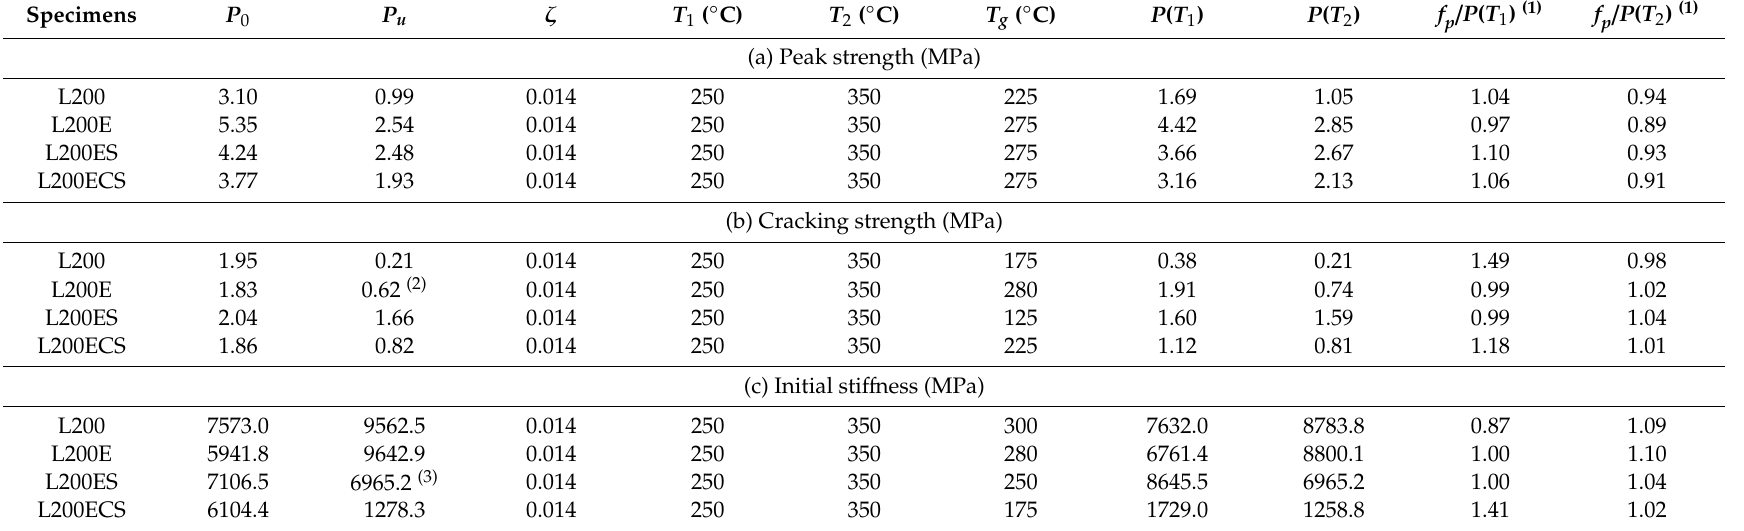
Table 3. Calibrated parameters used in prediction